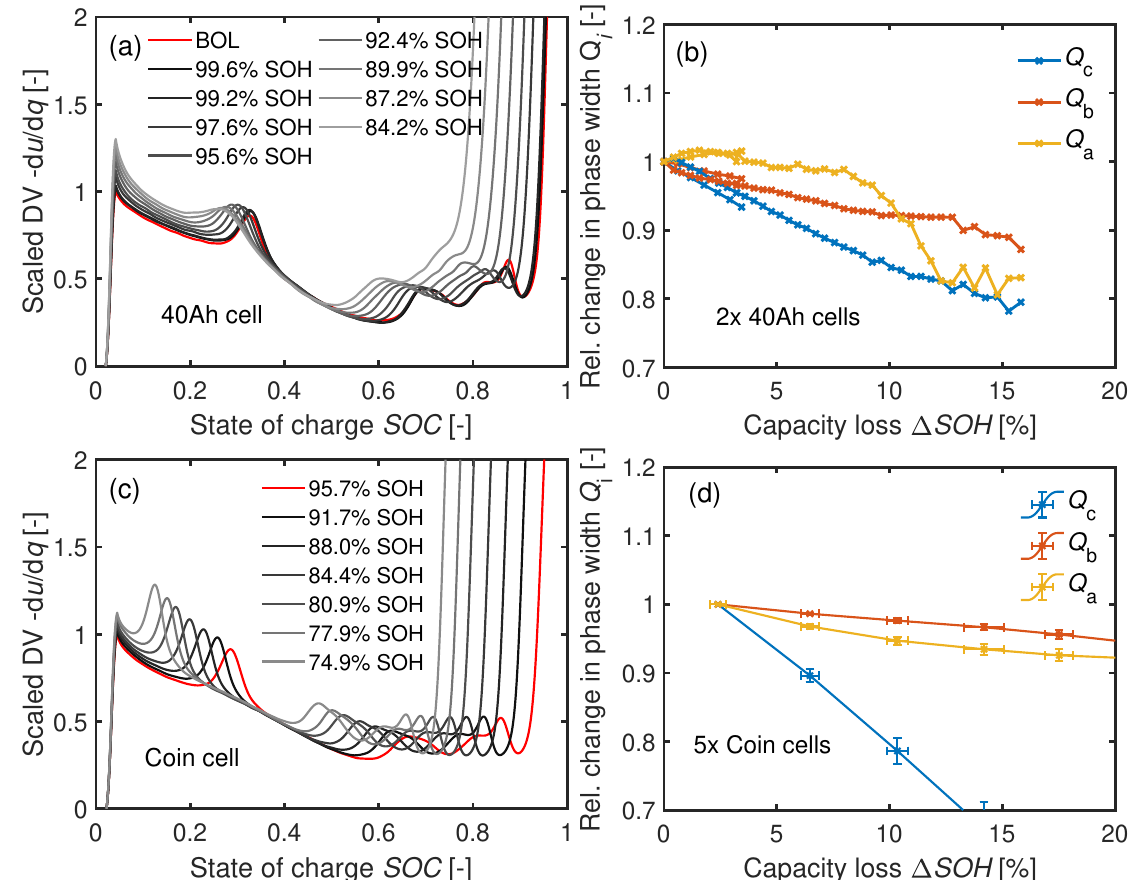
Figure 11. ( a ) DV of a cyclically aged 40Ah cell at T = 45 ◦ C and ( b ) the 40Ah cells’ corresponding relative phase widths. ( c ) DV of a cyclically aged coin cell at T = 45 ◦ C. ( d ) Development of the phase widths of five coin cells at T = 45 ◦